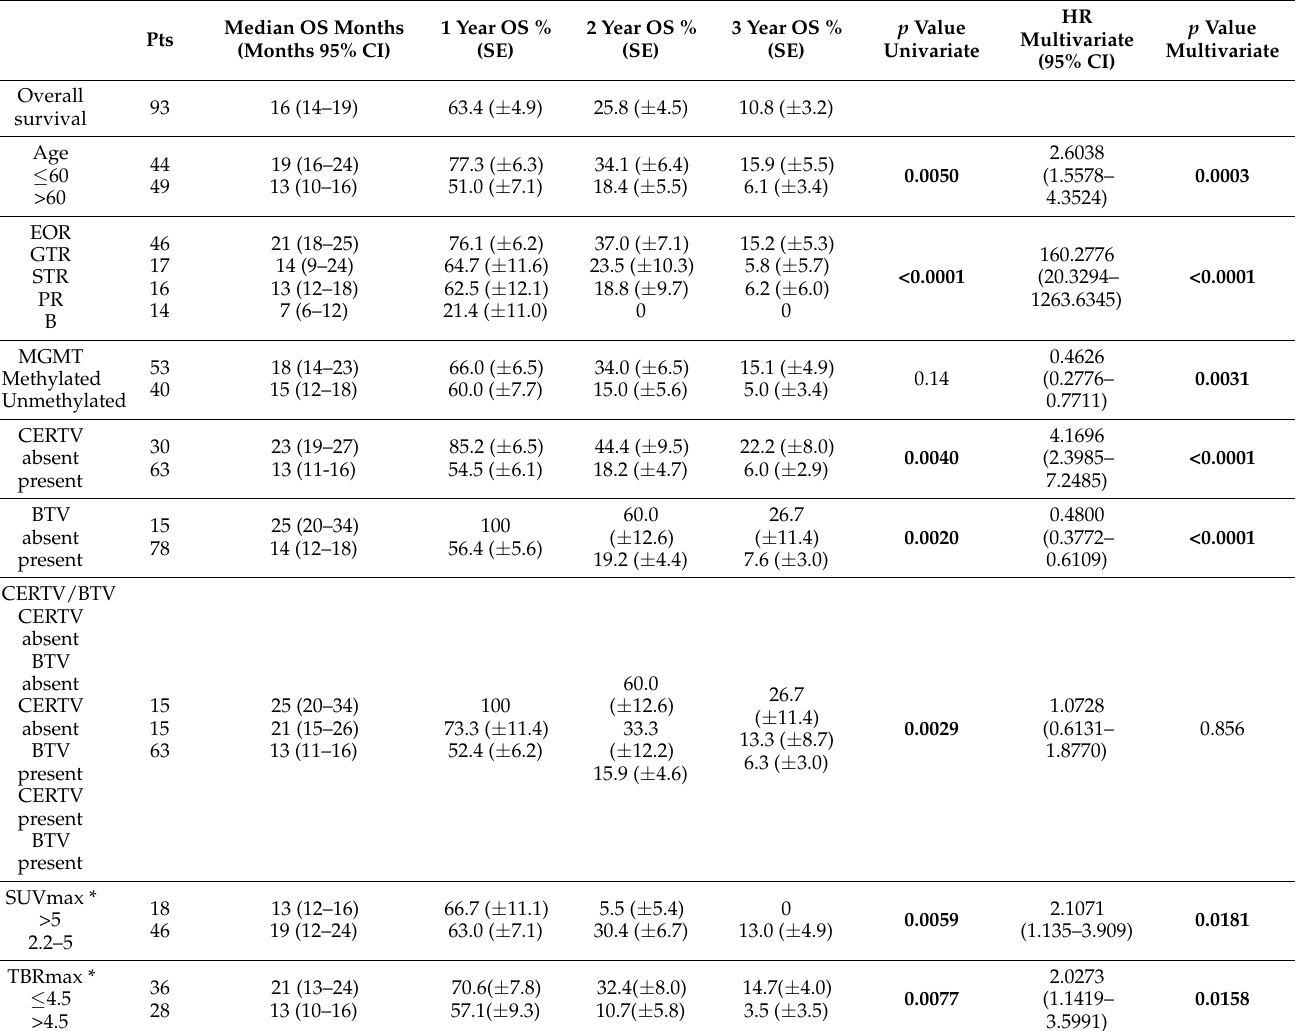
Table 4. Kaplan–Meyer overall survival (OS) according to subgroup